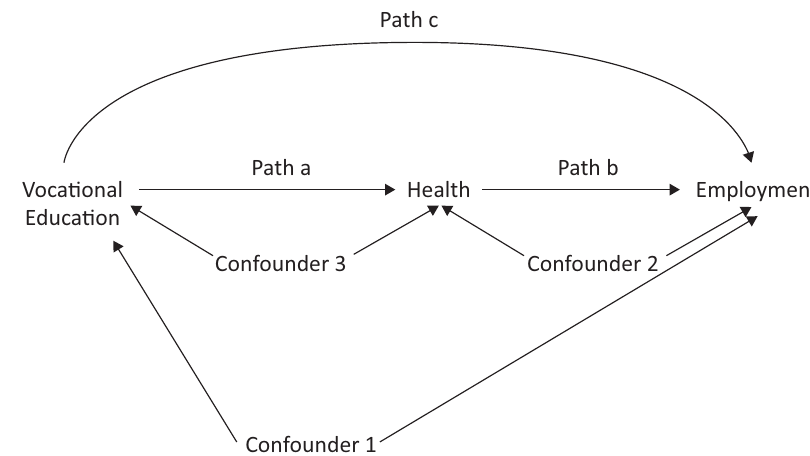
Figure 1. Paths from vocational education to employment and un-confounding